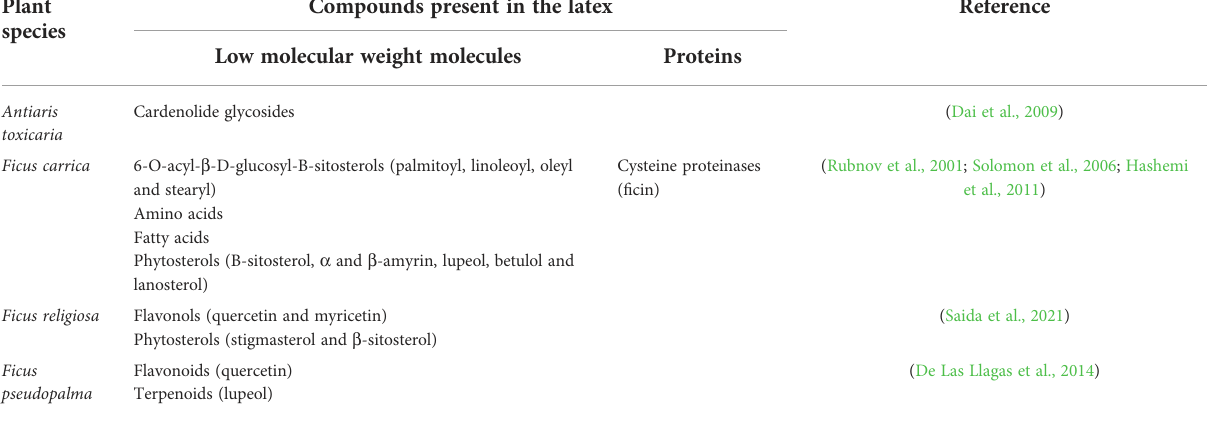
TABLE 5 Biological compounds with potential anticancer activity present in the latex from Moraceae family representatives.